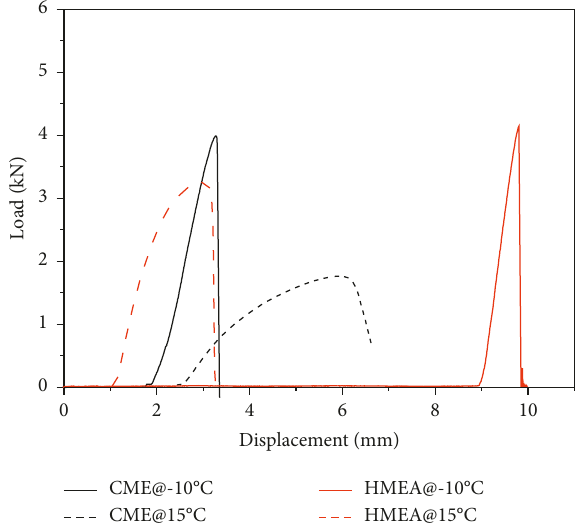
Figure 9: Load-displacement curves of the three-point bending test.